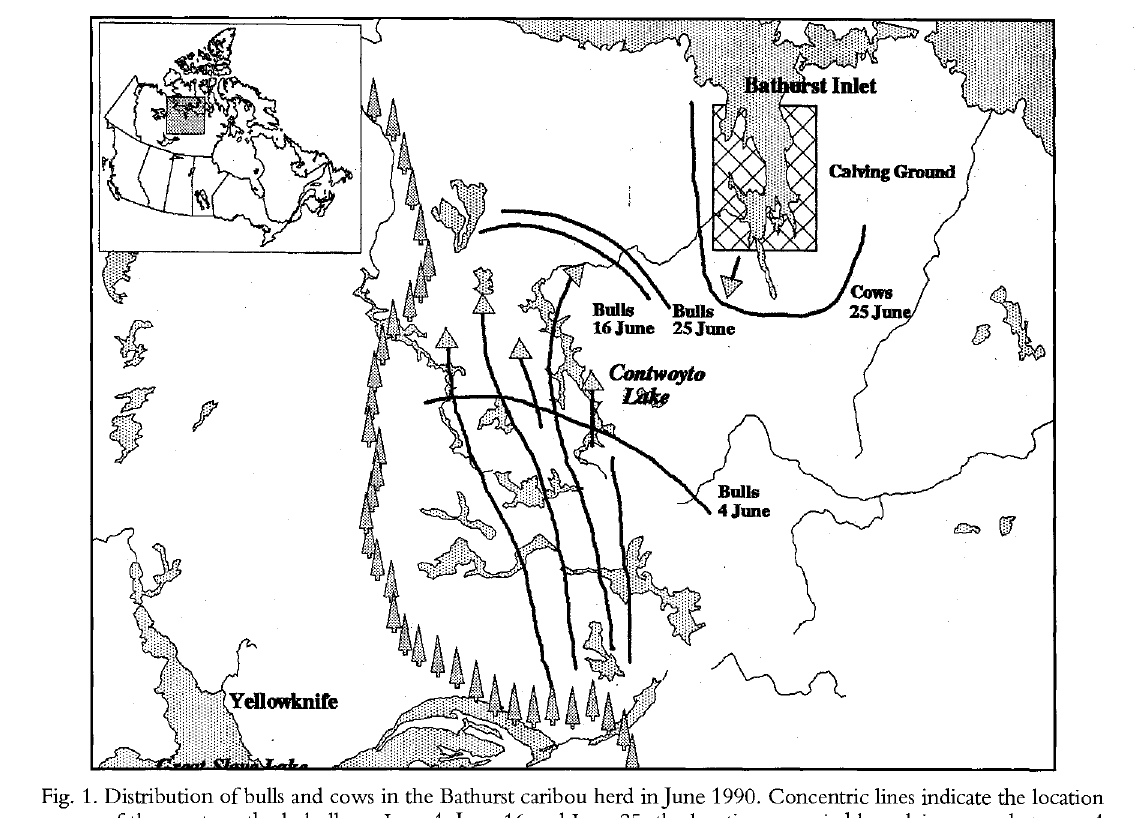
Fig. 1. Distribution of bulls and cows in the Bathurst caribou herd in June 1990. Concentric lines indicate the location of the most northerly bulls on June 4, June 16 and June 25, the location occupied by calving cows between 4 and 16 June and the location of the most southerly of the cows and neonates on 25 June.